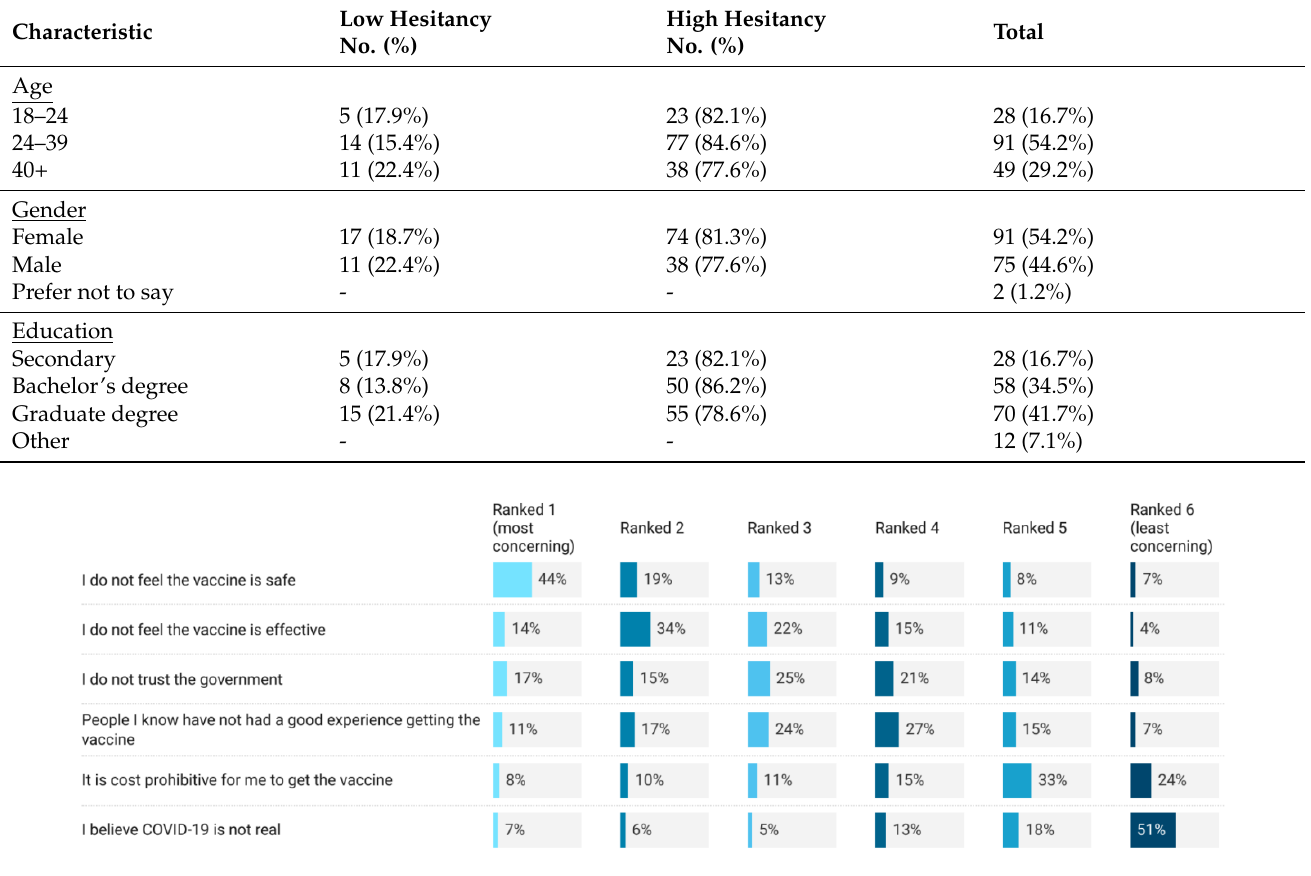
Figure 2. Ranked reasons why someone may not want to receive the COVID-19 vaccine. Table 3. Participant Preferences for Six Possible COVID-19 Vaccine Ads ( n =